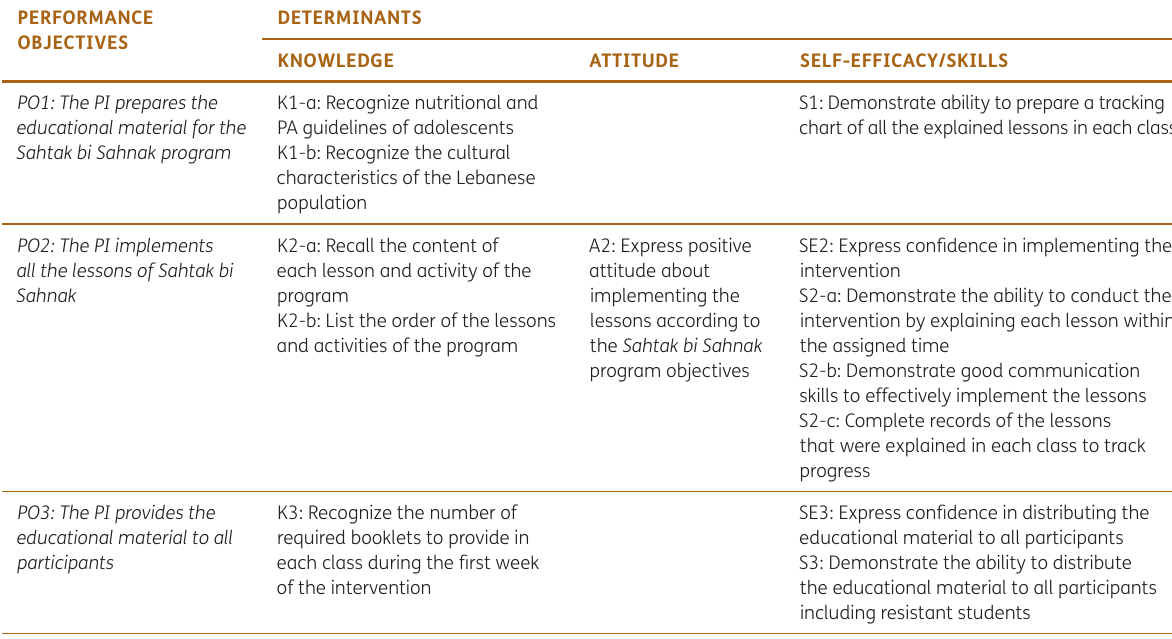
Table 4 Program use outcomes, performance objectives, and change objectives for